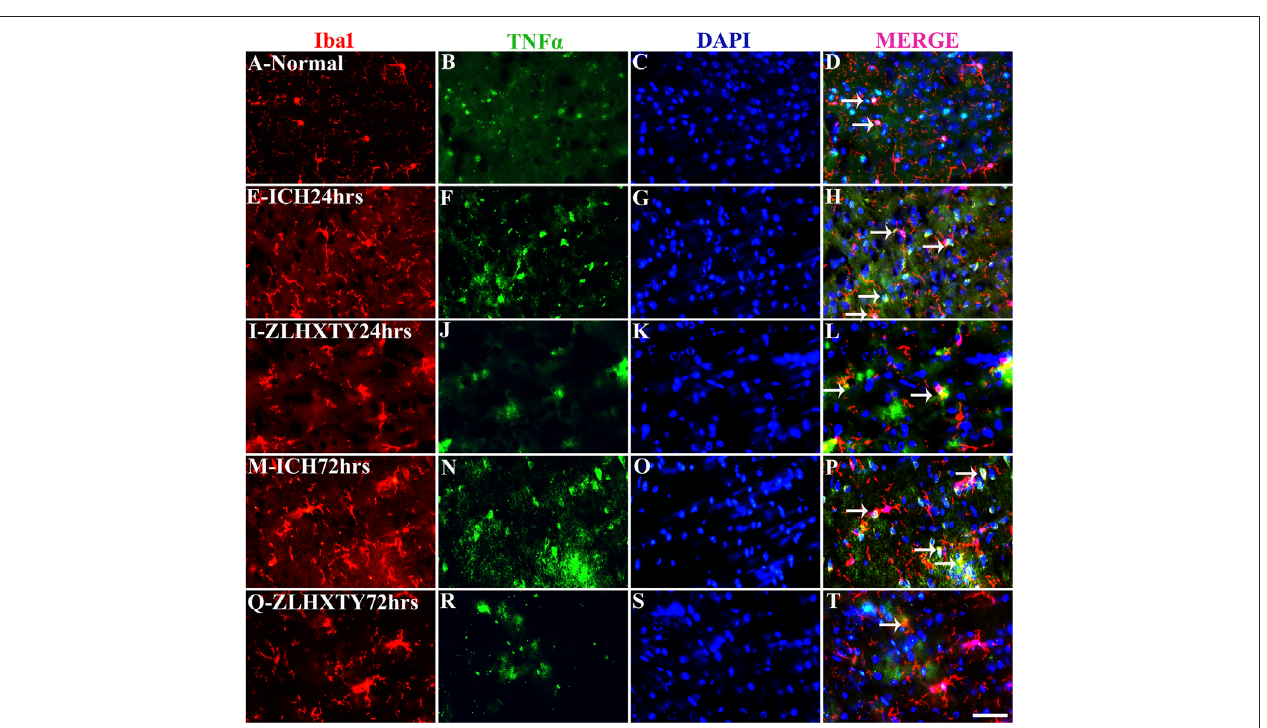
FIGURE 8 | Double immuno fl uorescence of Iba1 and TNF α . Brain sections were triple-stained with anti-Iba1 (red), anti-TNF α (green) and DAPI (blue) to mark microglia, TNF α and nucleus. (A – D) , Normal brain section with few Iba1 positive cells and weak TNF α expressing cells. (E – H) , ICH 24 h group show little increase in number of Iba1 and marked increase in TNF α expression with colocalization signals as well. (I – L) , ZLHXTY 24 h group shows decreased Iba1 and TNF α expression as compared to ICH 24 h group. (M – P) , ICH 72 h show marked increase in both the signals of Iba1 and TNF α with co-localization. (Q – T) , ZLHXTY 72 h group show decreased expression signal ofboth Iba1and TNF α and only few co-localization signals.Respective change incolor inmerged fi gures D,H,L,P,T, corresponds toRed + Blue = Magenta; Red + Green = Yellow. 50 µm scale bar corresponds to 400 × magni fi cation.